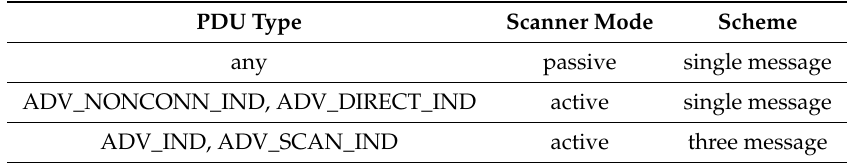
Table 1. Settings of the BLE nodes and scanners, and corresponding communication modes for connection-less BLE communication using legacy